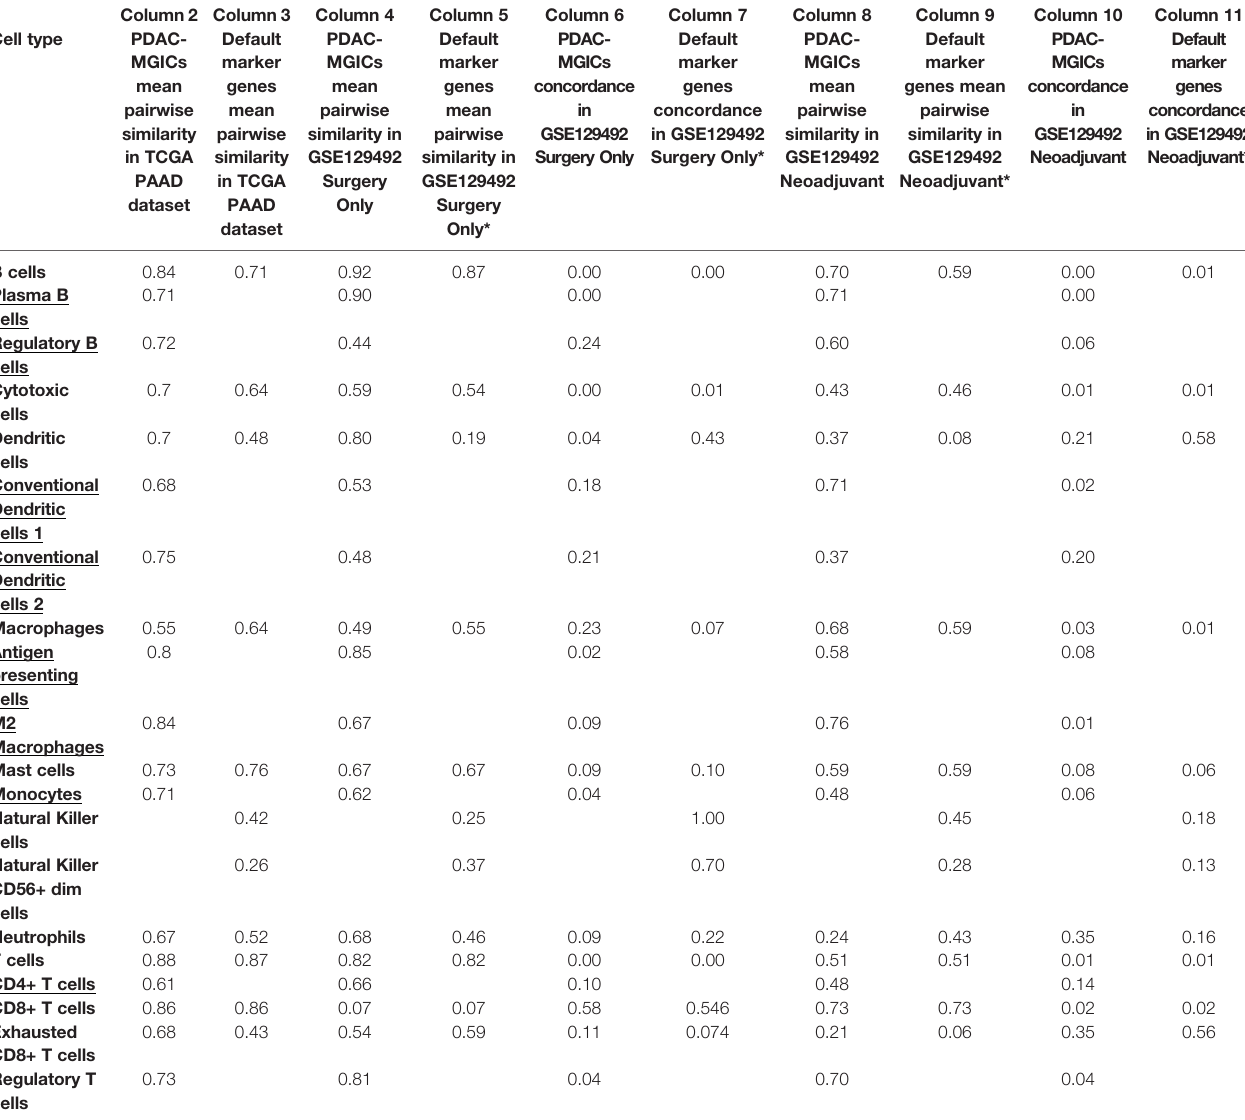
TABLE 2 | The pairwise similarities and concordance p -values of the PDAC-MGICs compared to the default marker genes of nSolver ® software, Advanced Analysis module. Column 2 Column 3 Column 4 Column